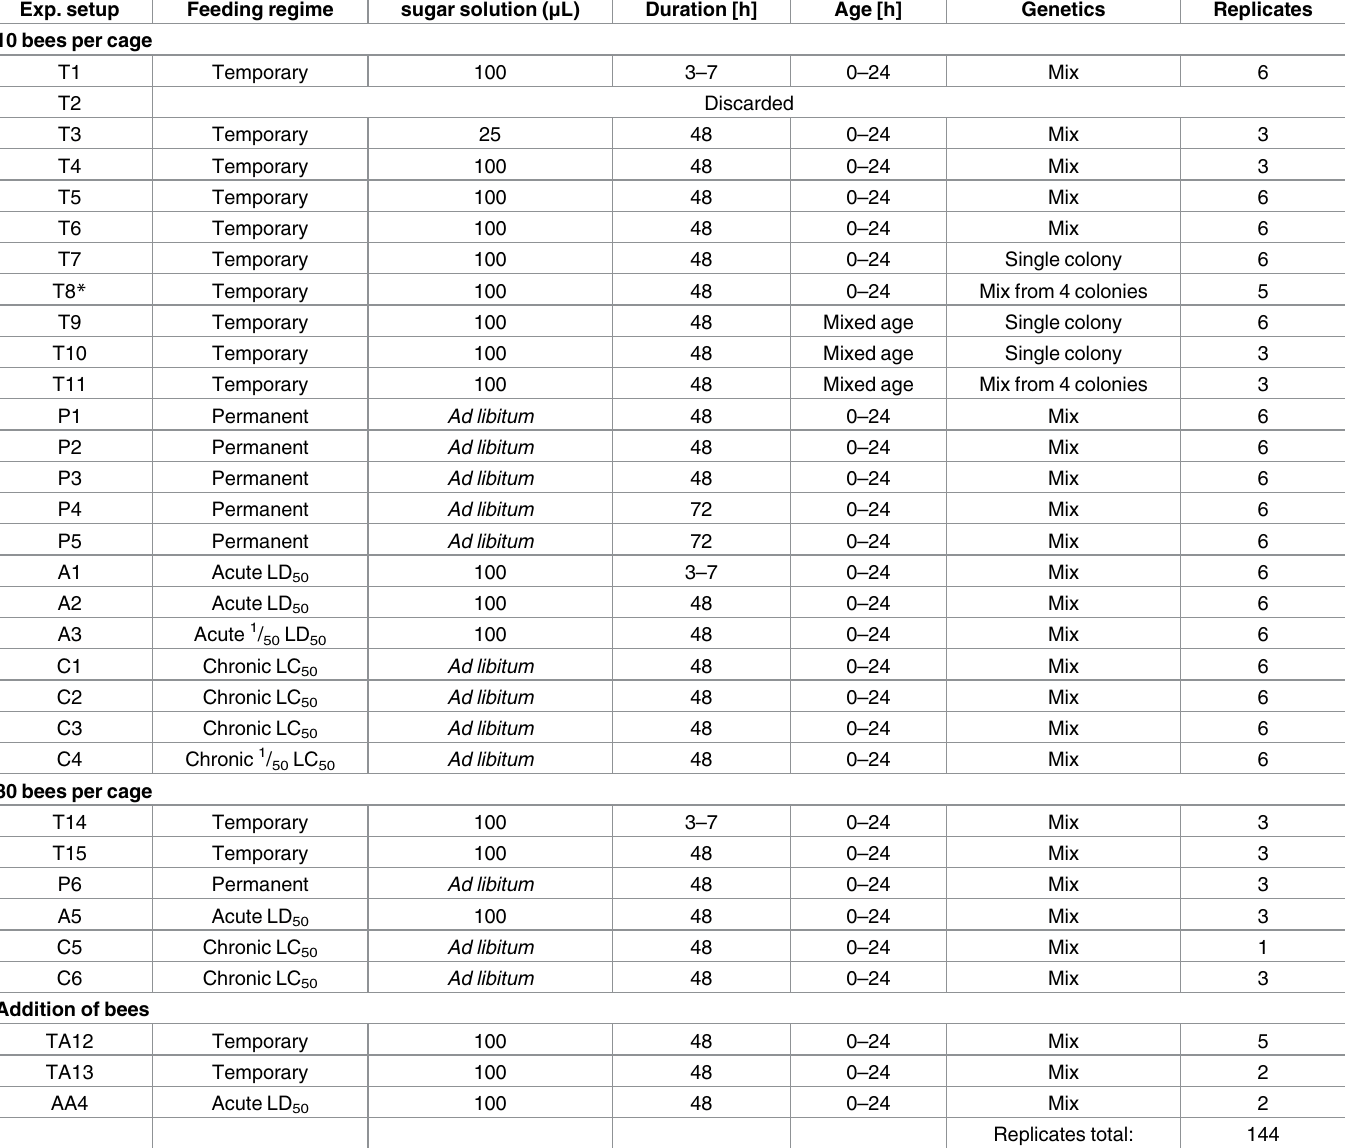
Table 1. Experimental outlines. Different experimental setups for temporary 1 (T), acute 2 (A), permanent 3 (P), chronic 4 (C) feedingregimes and post-feed- ing food circulation experiments (TA and AA) with varying numberof bees per cage. Amount of 14 C labelledsugar solution diet ( μ L), experimentduration (hours), age of bees (hours), genetic origin and numberof replicatesare shown. Exp.